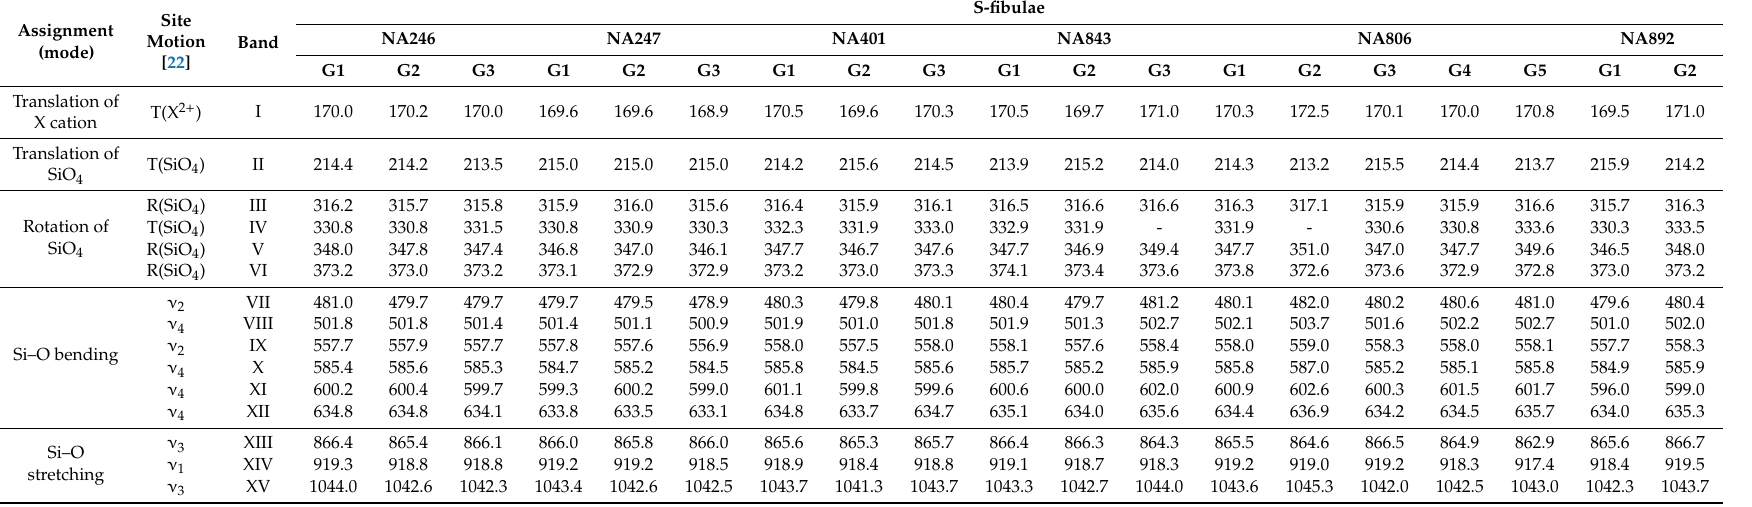
Table 3. Raman bands (cm − 1 ) for the investigated garnets, assigned to site motion and mode of